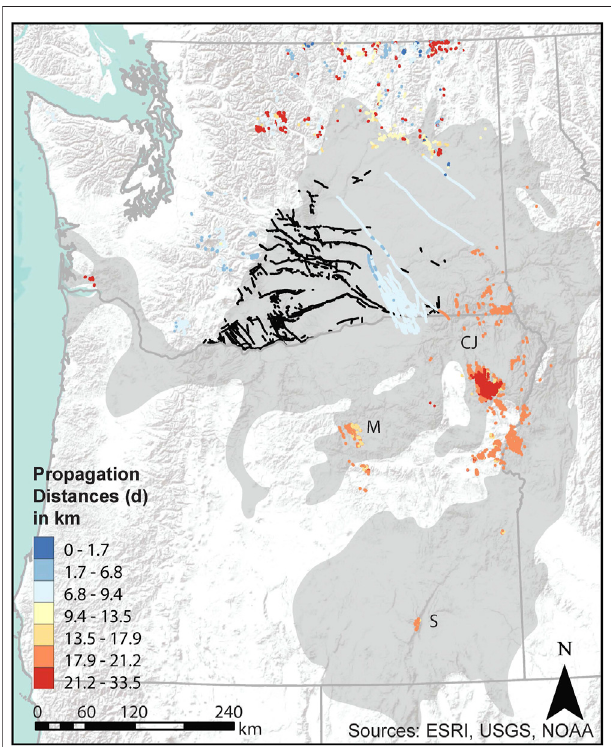
FIGURE 5 | This map shows the spatial relationships of the faults within the Yakima Fold Province (black lines), Columbia River Basalt Province (gray region; Camp and Ross, 2004), and dikes which have been color coded by their propagation distances. Warmer hues indicate deeper depths from which the dikes have propagated, and cooler hues indicate shallower propagation depths. Color coding is based on the Jenks method of classi fi cation which groups lengths in a way that maximizes across group differences. State boundaries are shown in gray. CJ (cid:1) Chief Joseph Dike Swarm, M (cid:1) Monument Dike Swarm, S (cid:1) Steens